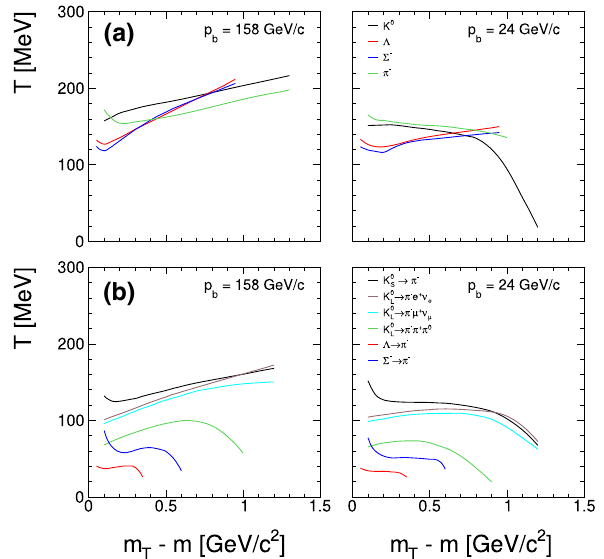
Fig. 25 a m T − m distributions for inclusive π − , K 0 , Λ and Σ − for Fig. 26 a Local inverse m T slopes for inclusive π − , K 0 , Λ and Σ − as the beam momenta of 158 and 24 GeV/c; b corresponding distributions a function of m T -m at 158 and 24 GeV/c beam momentum; b inverse for the decay pions including the 3 body decays of K 0 slopes for the decay π − from 2 and 3 body decays L